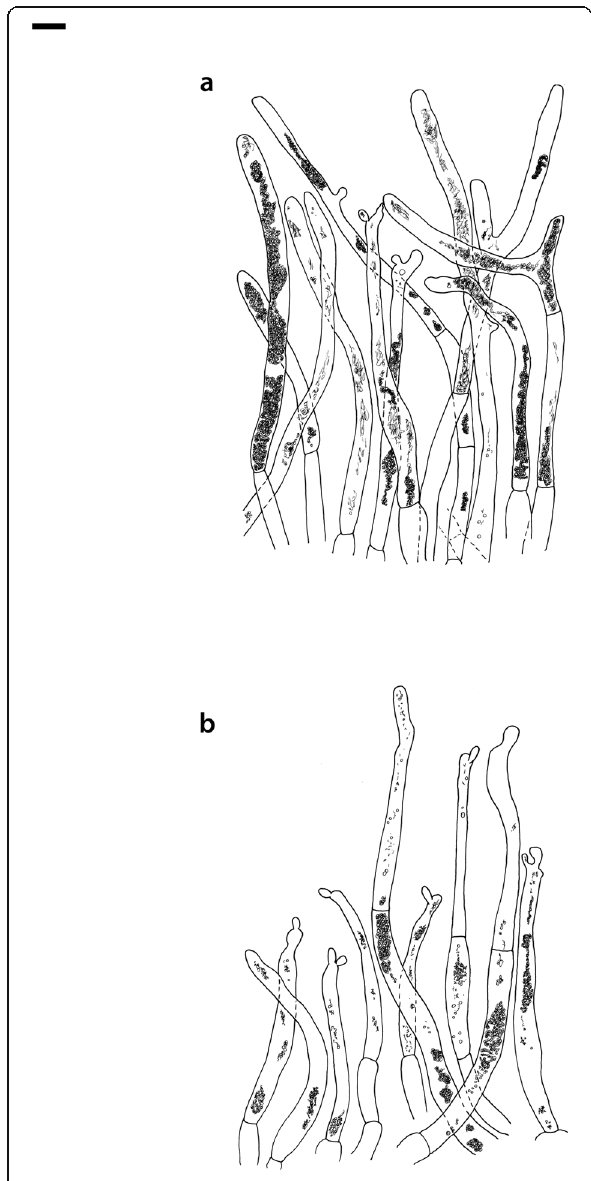
Fig. 6 Russula albonigra (SAV F-20177), pileocystidia. a Near the pileus margin. b Near the pileus centre. Bar = 10 μ